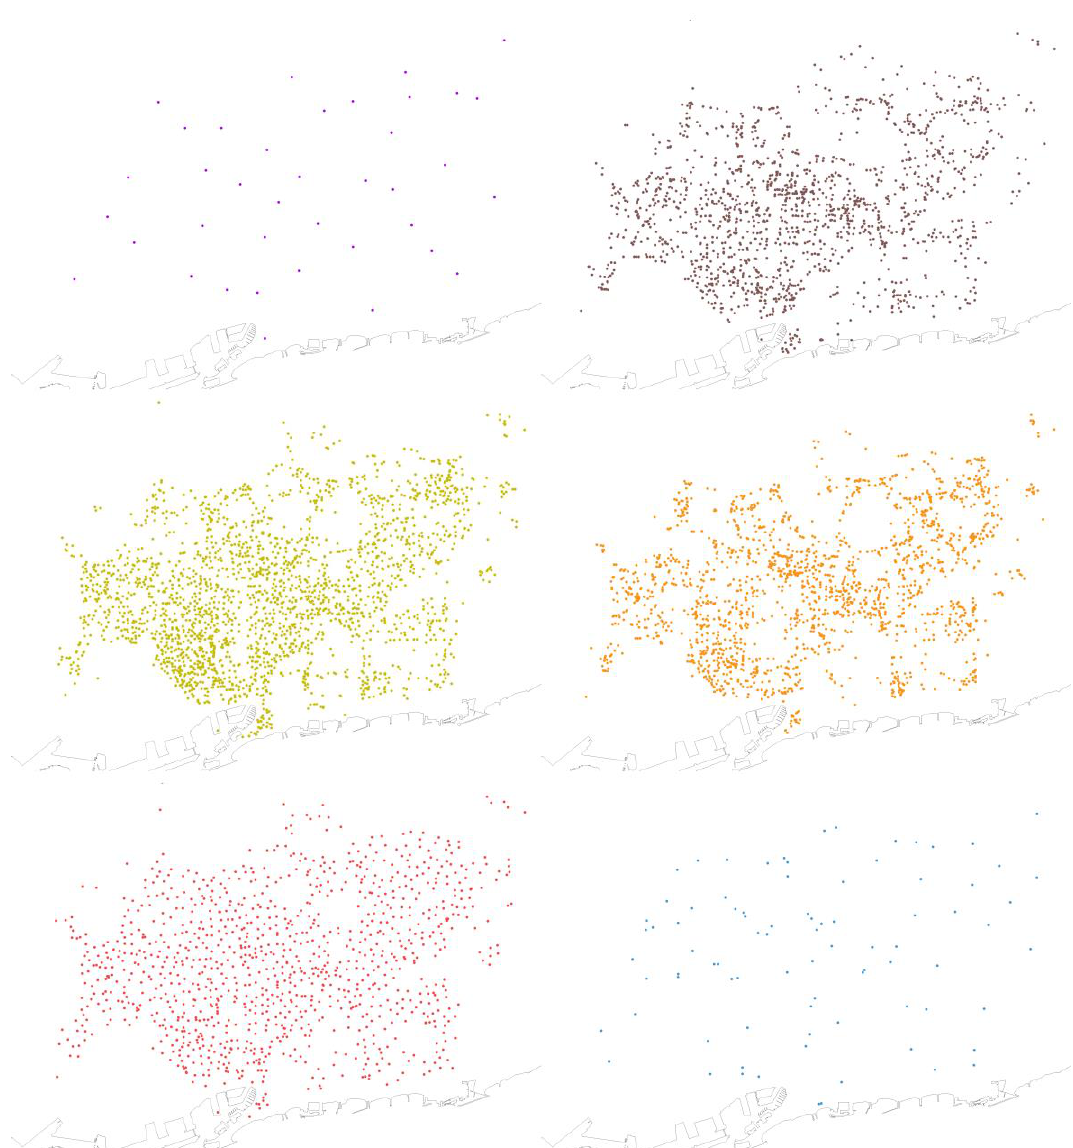
Figure 3. Distribution of essential services by categories (from left to right and top to bottom: market halls, bakeries, supermarkets, grocery stores, pharmacies and healthcare facilities). Table A1 in the